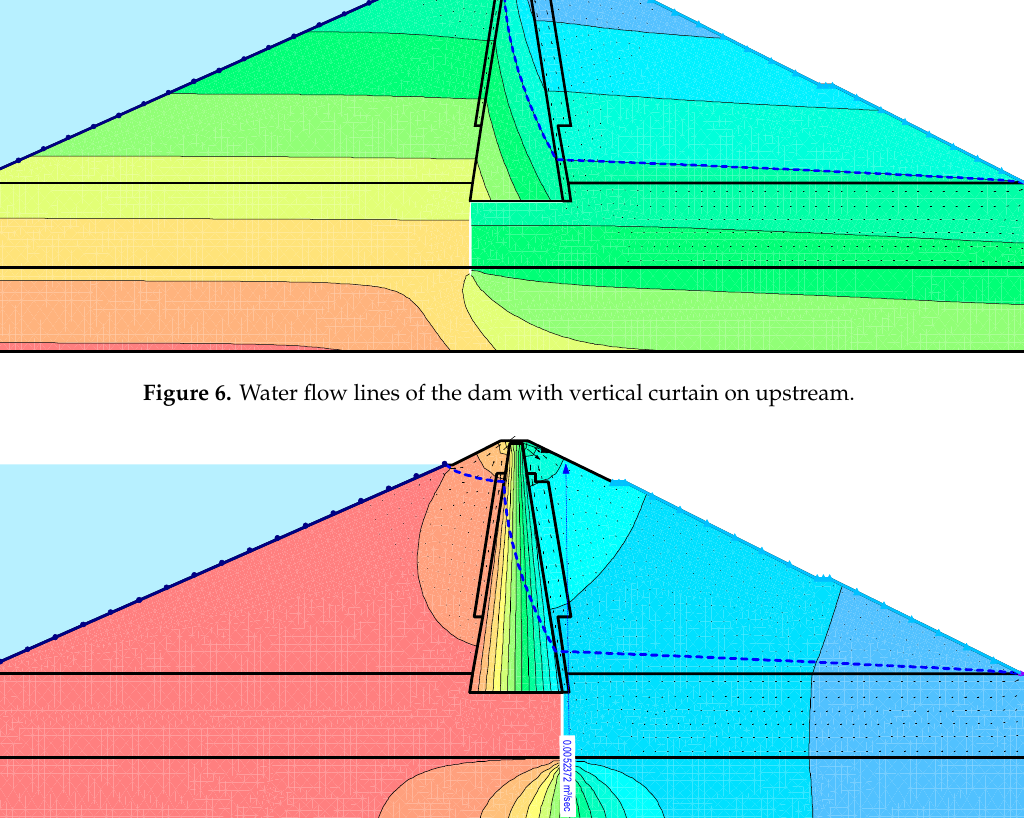
Figure 7. Equipotential lines of the Dam with vertical curtain on downstream.